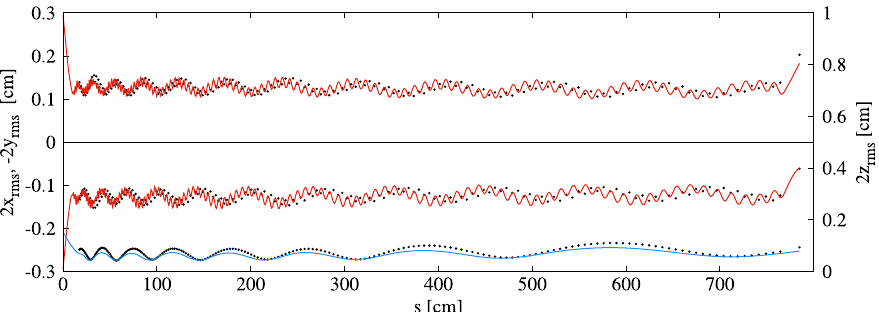
FIG. 5. ISAC-RFQ envelope simulation of a 14 N þ beam, with injection parameters as shown in Table II and accelerated to 2.15 MeV. PARMTEQ rms envelope values are shown as black dots. TRANSOPTR transverse envelopes are shown in continuous red lines with dimensions on the left-hand vertical axis. The y -envelope is shown with negative values, and the x -envelope positive. The longitudinal envelopes for both codes are shown in the bottom half with dimensions shown on the right-hand vertical axis, with TRANSOPTR in continuous